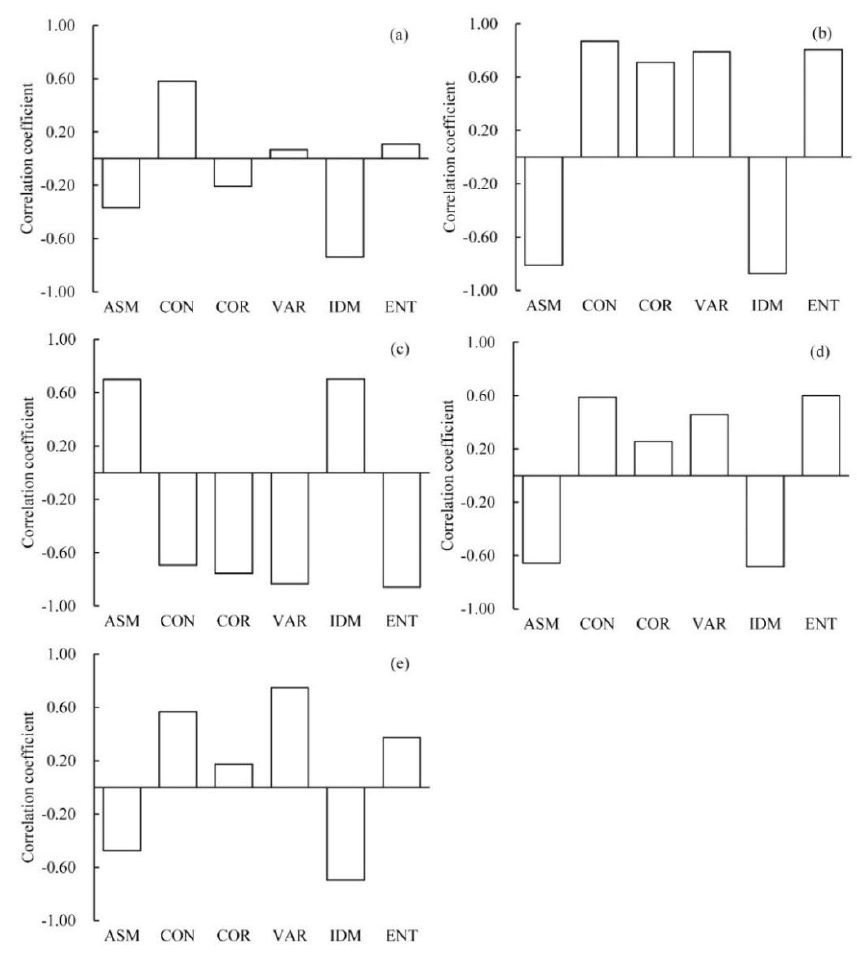
Figure 8. Relationships between the biomass and GLCM-based textural parameters calculated from the ( a ) blue band, ( b ) green band, ( c ) red band, ( d ) red-edge band, and ( e ) near infrared band. ASM: Angular Second Moment; CON: Contrast; COR: Correlation; VAR: Variance; IDM: Inverse Difference Moment; ENT: Entropy.